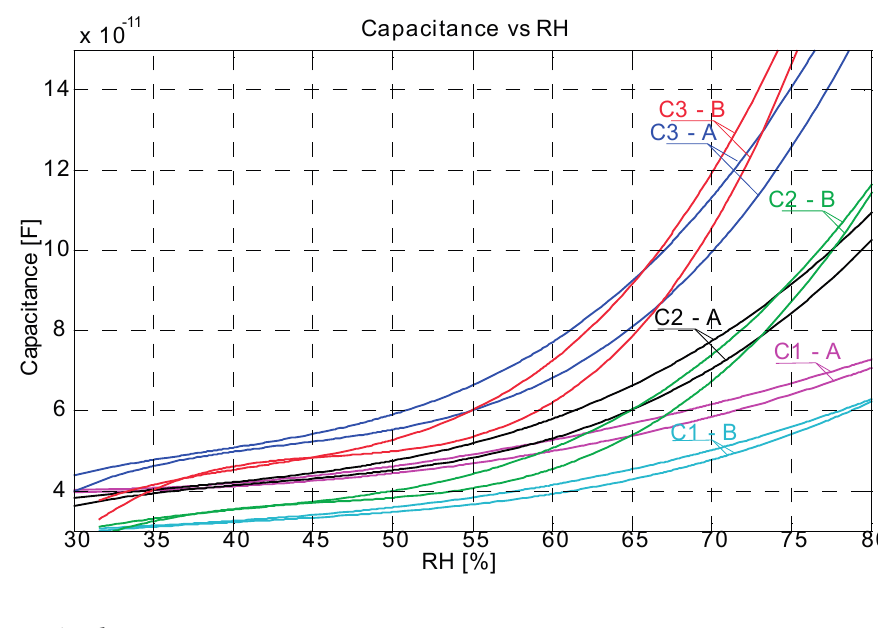
Figure 13. Capacitance vs. RH plot for two measurement series (A and